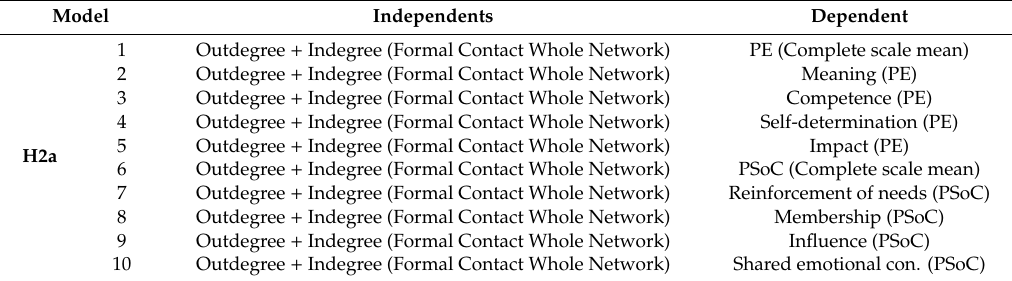
Table A1. Description of regression models indicating the hypothesis